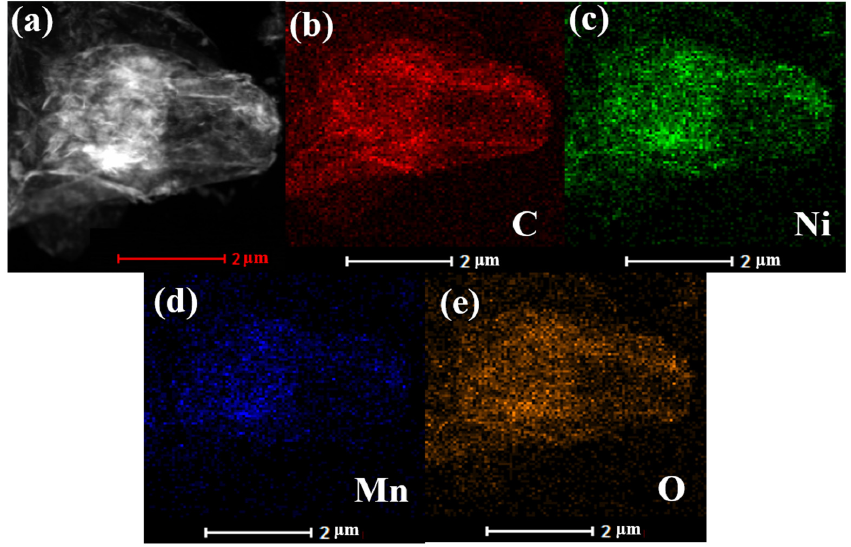
Figure 2. TEM Mapping diagram of rGO-NiMnO 3. ( a ) TEM diagram of rGO-NiMnO 3 ; ( b ) The dis- tribution of C elements; ( c ) The distribution of Ni elements; ( d ) The distribution of Mn elements; ( e ) The distribution of O elements.